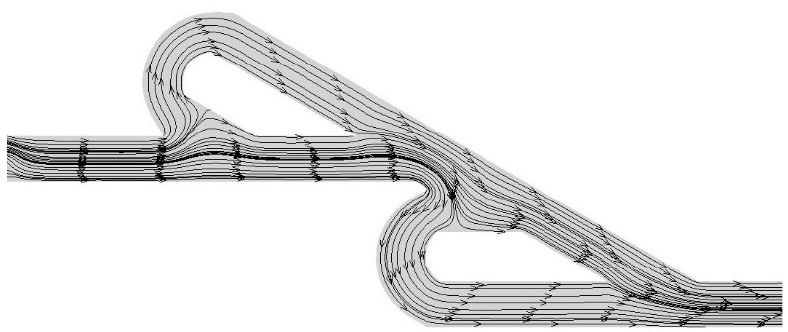
Figure 6. Streamlines into the micromixer for the velocity ratio equal V p /V c = 20 for the longest inlet.